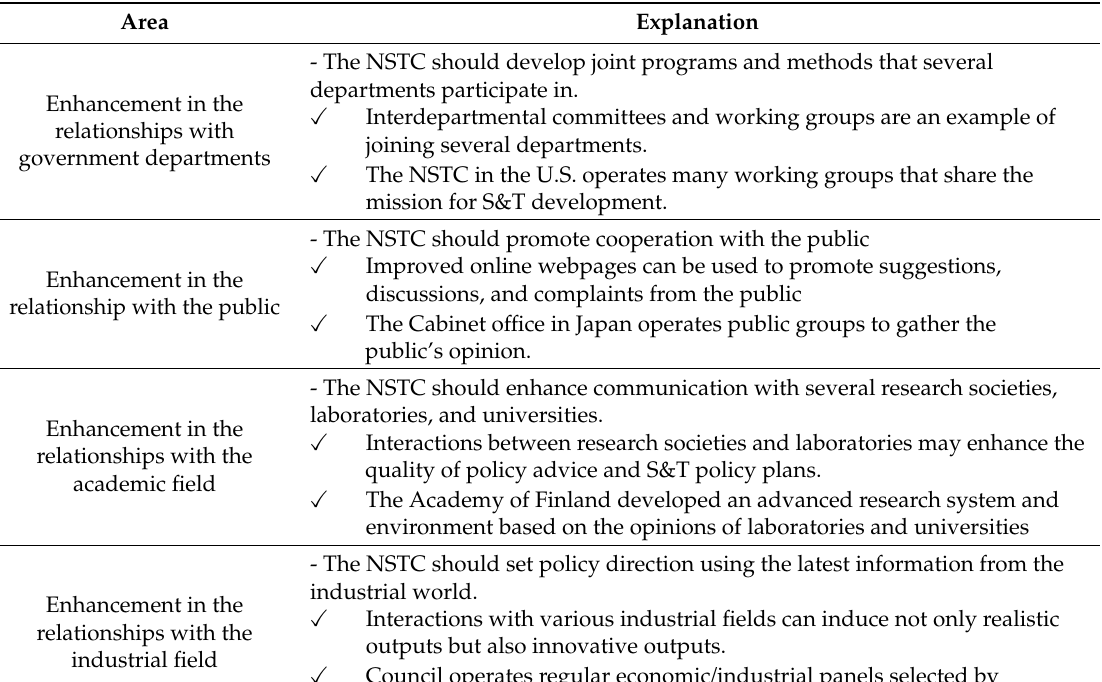
Table 9. Basic directions for the improvement of